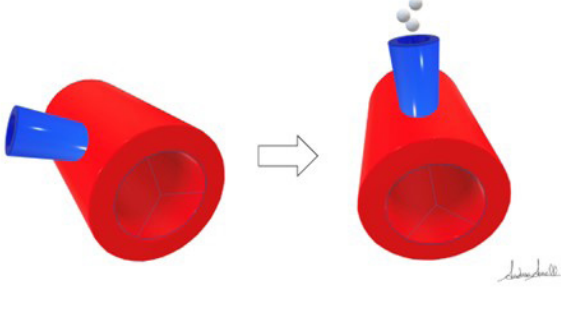
Fig. 1 - Schematization of the ascending aorta (red) and the aortic cardioplegia cannula (blue) from a caudo-cranial perspective. In normal positioning (left), the cannula enters the ascending aorta with an acute angle. After rotating the patient to his left side (right), the cardioplegia cannula becomes perpendicular to the horizontal plane and thus facilitates the outflow of air bubbles.